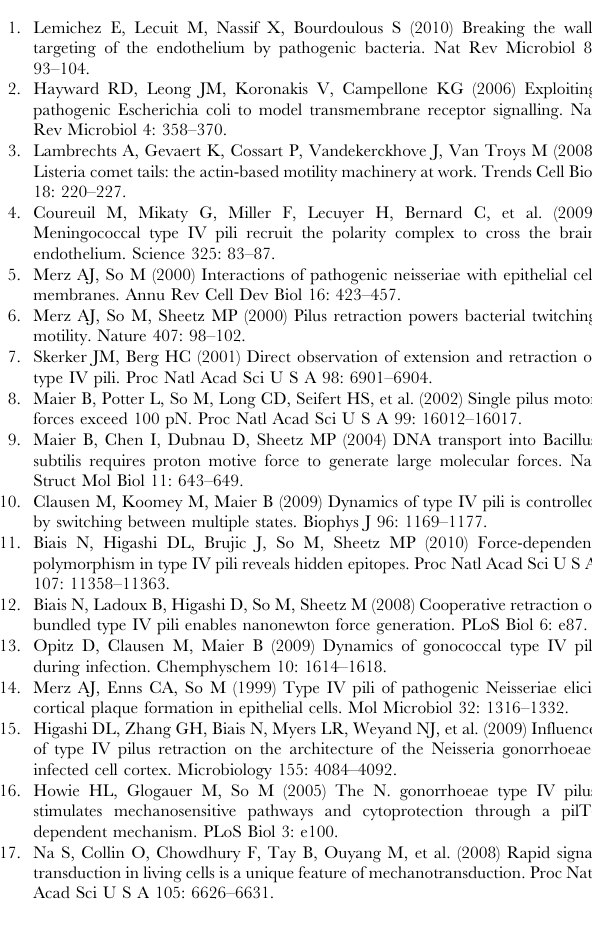
Figure S1 Immunofluorescence (rabbit anti-PilE (Micheal Koomey) and Alexa Fluor 488 goat antirabbit, Invitrogen) of 2 m m latex beads coated with the results of crude pilus